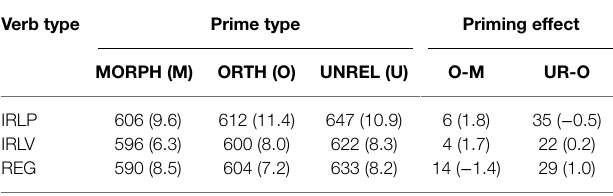
TABLE 2 | Mean response latencies and (error rates) of targets primed by morphological, orthographic, and unrelated primes for Experiment 1. Verb type Prime type Priming